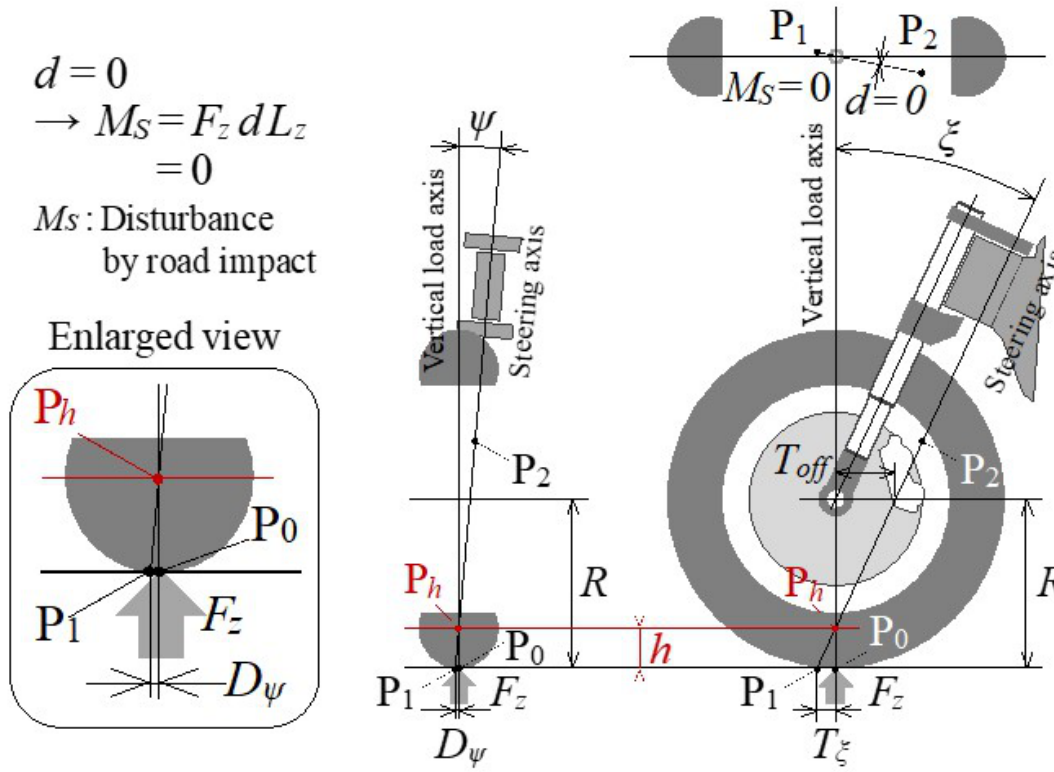
Figure 10. Steering axis to minimize M s by F z on upright